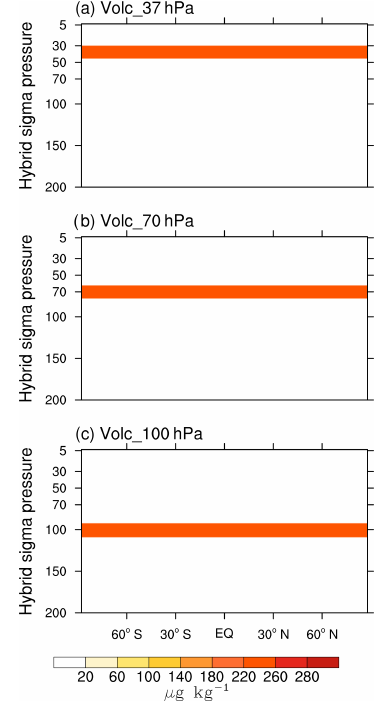
Figure 1. Vertical distribution of the volcanic aerosols used in our stratospheric sulfate aerosol simulations. The aerosol layers are cen- tered at (a) 37hPa (b) 70hPa, and (c) 100hPa with a thickness of approximately